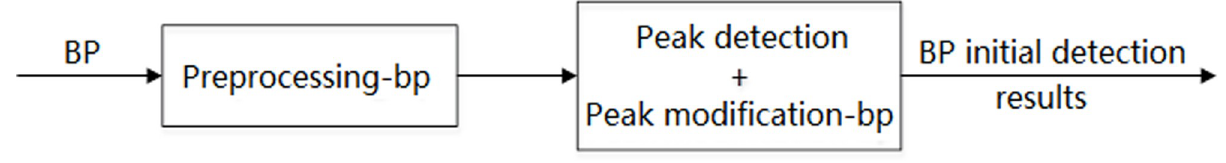
Fig 7. Flowchart of BP